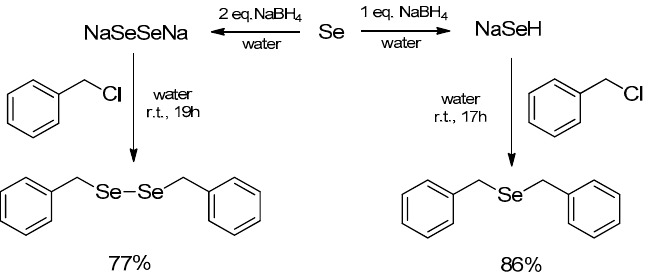
Figure 1. Water as a protic solvent for the synthesis of selenides and diselenides.